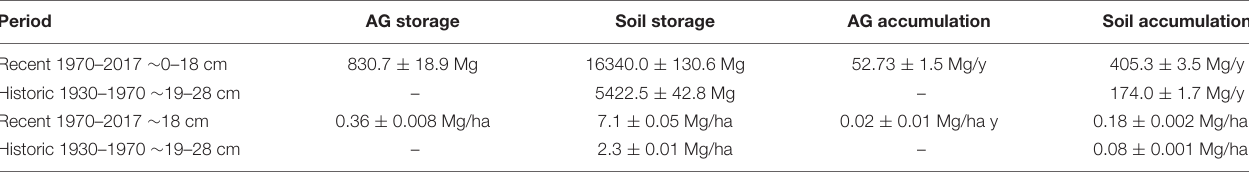
TABLE 2 | Total nitrogen storage and accumulation rates for the mangroves of the San Juan Bay Estuary.